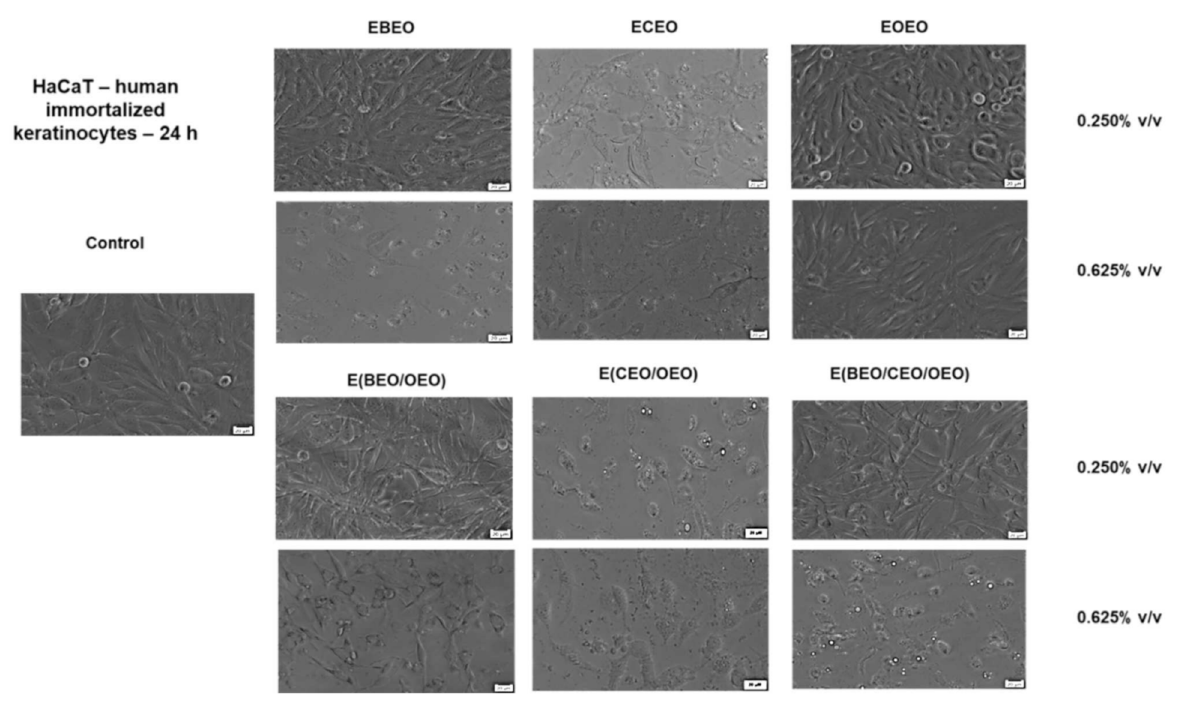
Figure 2. The morphological aspect of HaCaT—in culture: Control—unstimulated cells and cells stimulated with different test compounds: ECEO, EOEO, EBEO, E(BEO/OEO), E(CEO/OEO), and E(BEO/CEO/OEO) for 24 h. The scale bar is 20 µ